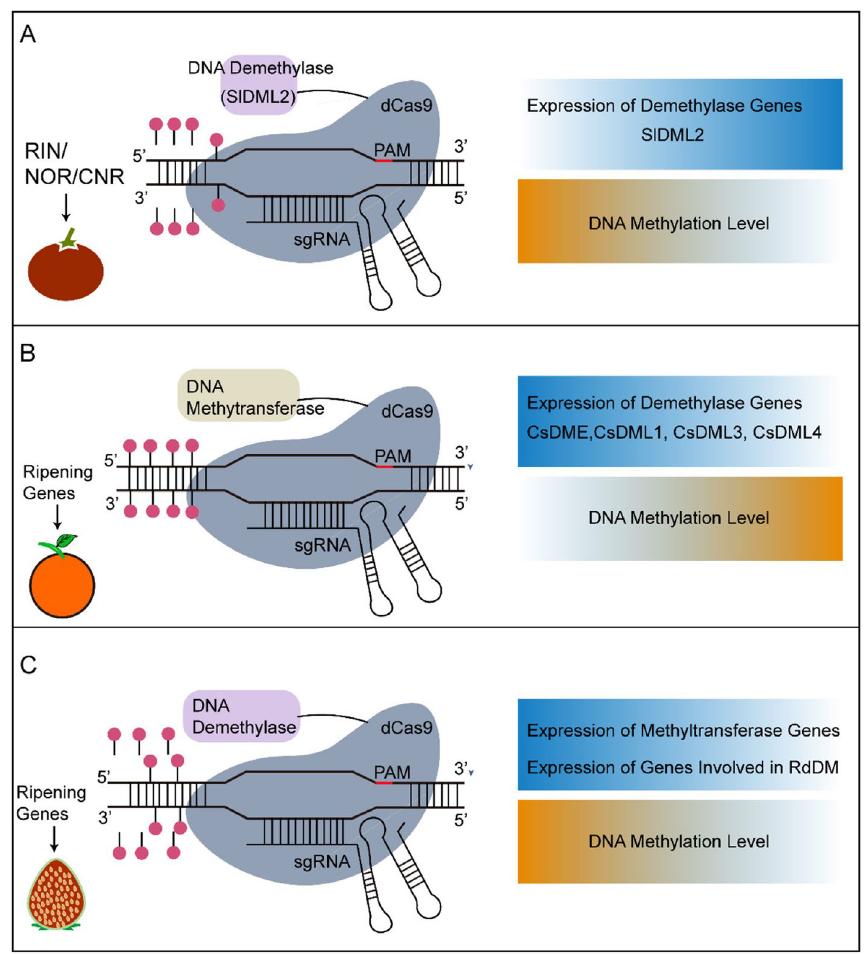
Fig. 5 CRISPR/dCas9-based epigenetic modifier during fruit ripening process in tomato, sweet orange, and strawberry. A CRISPR/dCas9 based epigenetic modifier in tomato fruit ripening. The DNA demethylase can be engineered to fuse to dCas9 system. In tomato fruit ripening process, the expression of DNA demethylase DME-LIKE 2 ( DML2 ) increases, leading to decrease of 5-methlcytosine (5mC) DNA level at various gene loci, such as RIN, CNR, and NOR. B CRISPR/dCas9 based epigenetic modifier in sweet orange fruit ripening process. DNA methyltransferase could be engineered to fuse to dCas9 system. During sweet orange fruit ripening, DNA demethylase genes are downregulated, leading to the upregulation of 5mC DNA methylation level. C CRISPR/dCas9 based epigenetic modifier in strawberry fruit ripening process. DNA methyltransferase could be engineered to fuse to dCas9 system for promoting strawberry fruit ripening. As strawberry fruit ripening, the activity of RNA-directed DNA methylation is reduced, resulting in a decrease in the DNA methylation level. Diagrams were drawn based on publications (Liu et al. 2015; Cheng et al. 2018; Huang et